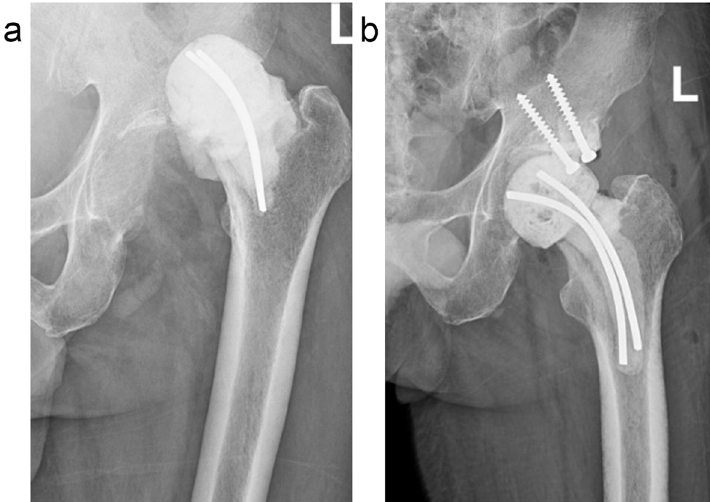
Fig. 2 Postoperative dislocation of a hand-made spacer ( a ); another molded spacer was used for spacer exchange and cemented screws were placed to manage the acetabular bone defect and increase hip stability ( b